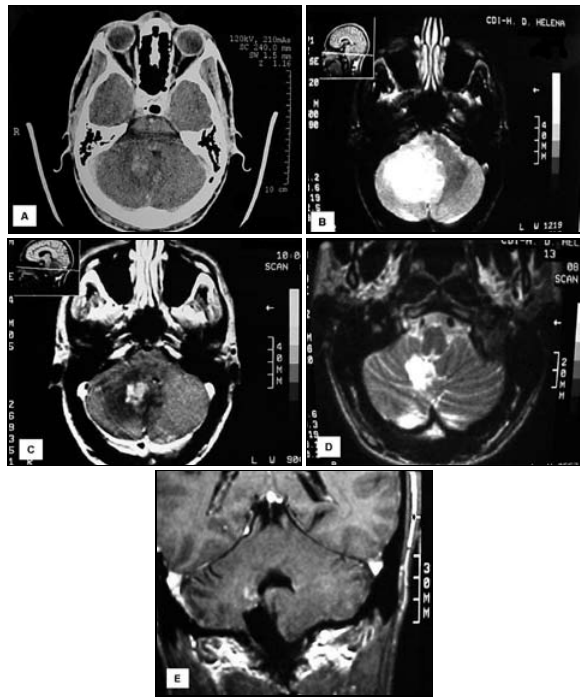
Figura 1 – A: TC com contraste evidenciou lesão expansiva com impregnação nodular no vérmis e no hemisfério cerebelar direito; B: RM ponderada em T2 evidenciou lesão expansiva com hipersinal na topografia do vérmis, do hemisfério cerebelar direito, à direita da ponte e do pedúnculo cerebral direito; C: RM ponderada em T1 após uso de contraste paramagnético evidenciou impregnação nodular heterogênea da lesão; D: RM pós-operatória com cortes axiais em T2 evidenciando pequena área de hipersinal no hemisfério cerebelar direito sem efeito de massa; E: RM pós-operatória com cortes coronais em T1 após contraste evidenciando pequeno realce nodular no hemisfério cerebelar direito e sugerindo reação granulomatosa